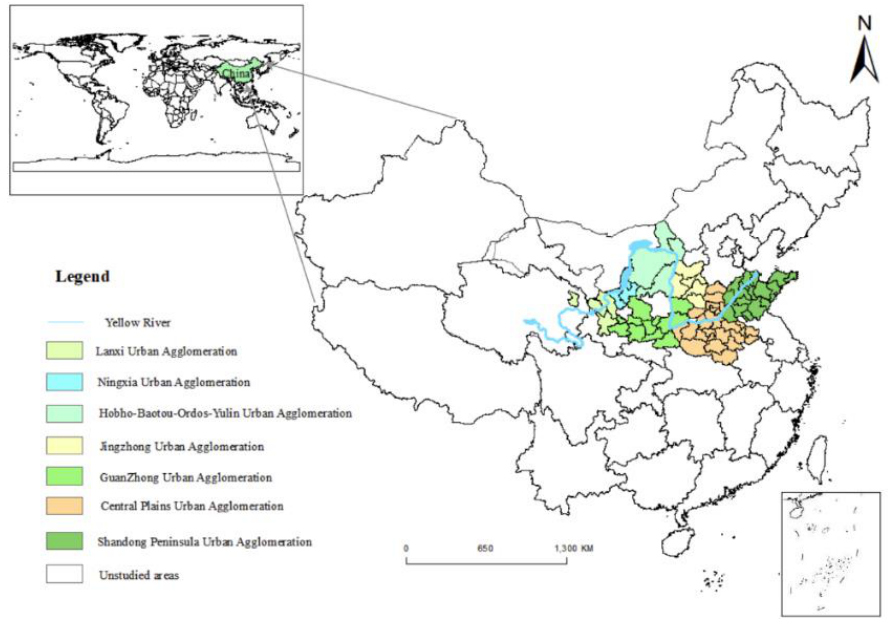
Figure 3. Division of urban agglomerations in the Yellow River Basin.